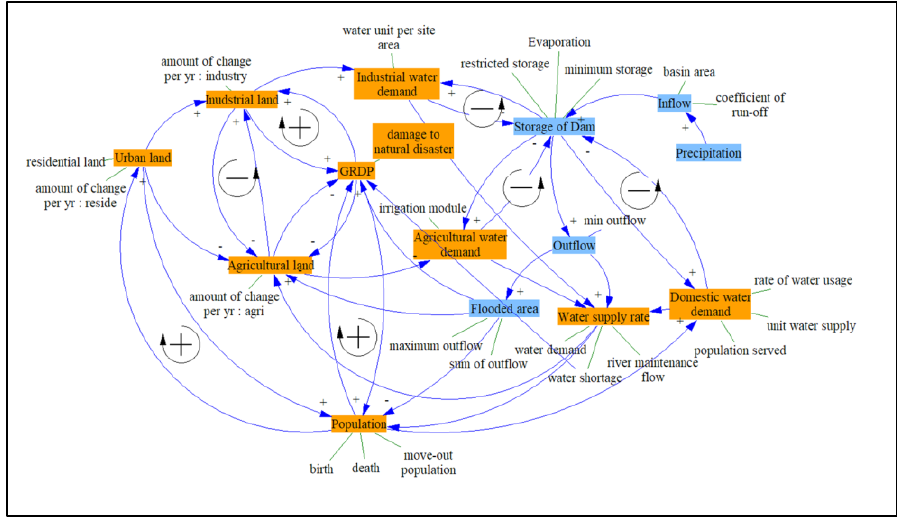
Figure 2. Schematic diagram of the causal loop in the proposed system dynamics model. The socio- and hydro-elements are represented in orange and blue, respectively.